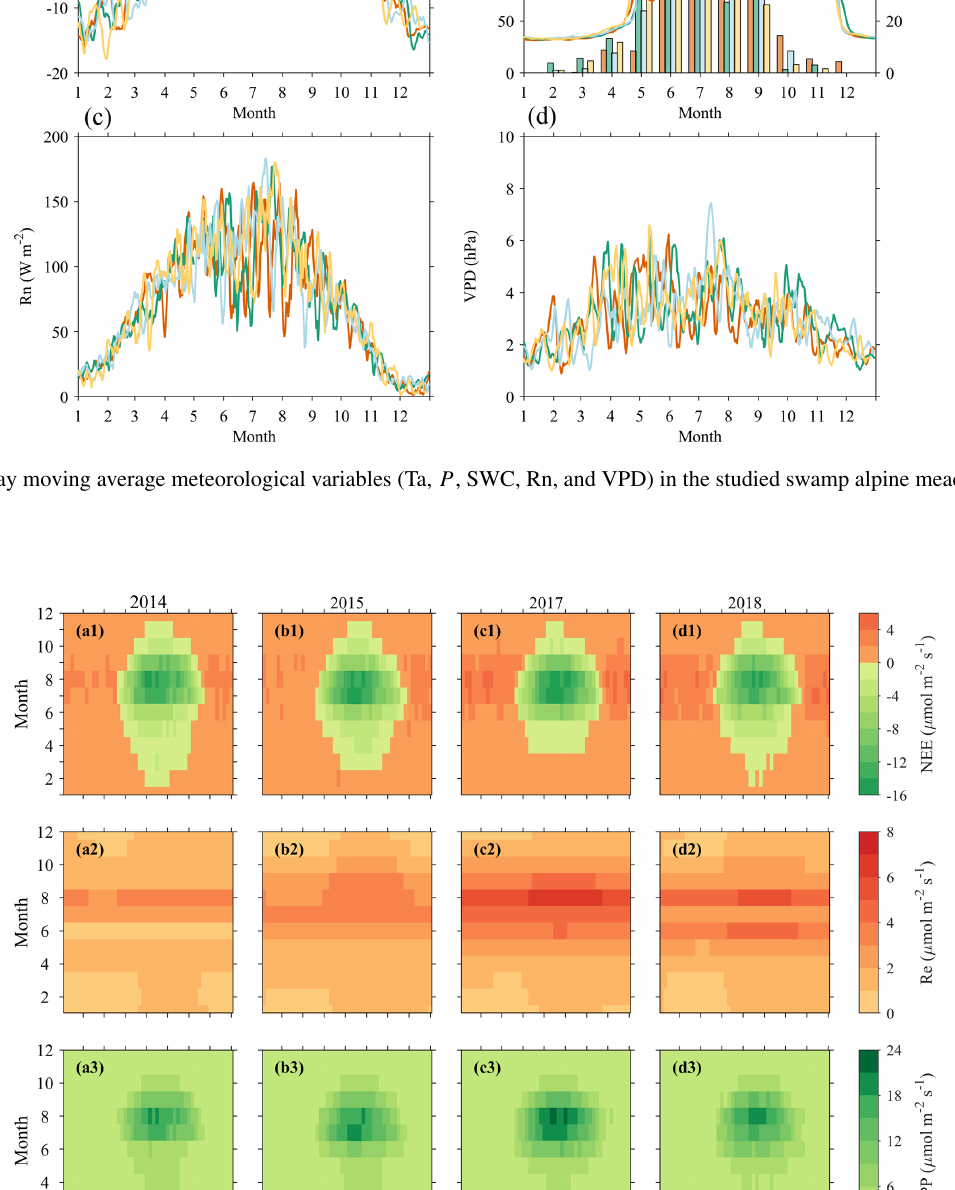
Biogeosciences, 19, 861–875, 2022